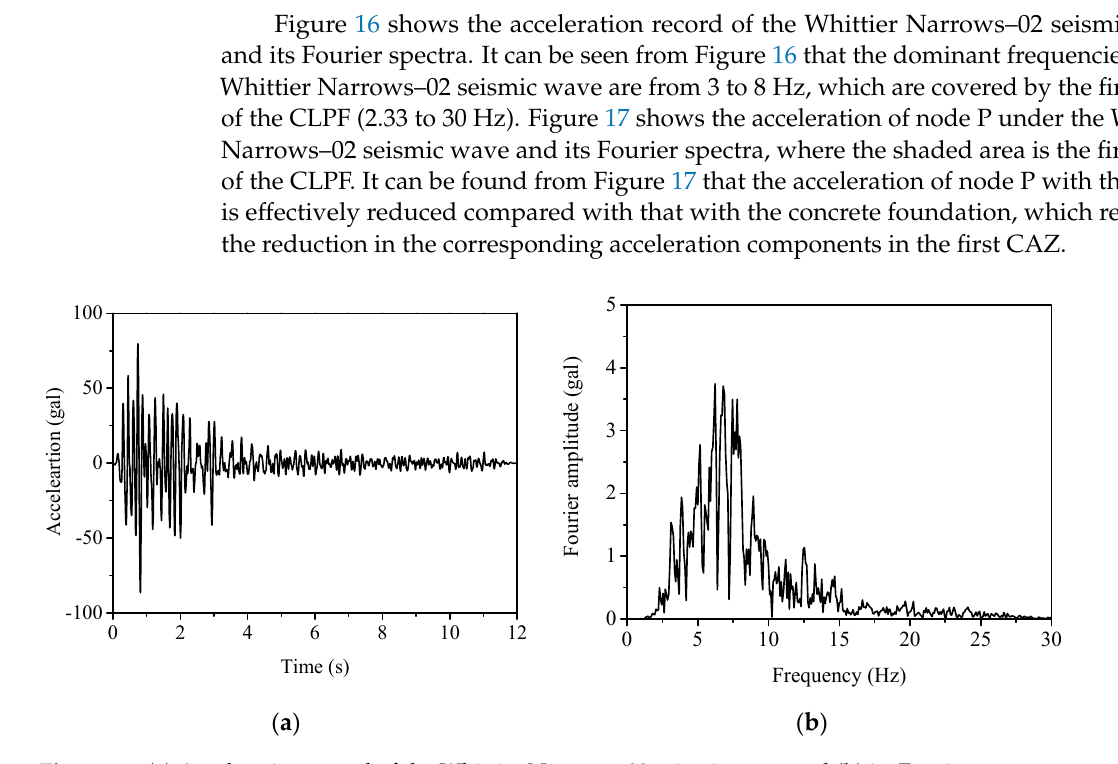
( b ) Figure 17. ( a ) Acceleration of node P under Whittier Narrows–02 seismic wave and ( b ) its Fourier spectra. Figure 18 shows the acceleration record of the Oroville–01 seismic wave and its Fou- rier spectra. It can be seen from Figure 18 that the dominant frequencies of the Oroville– 01 seismic wave are from 2.5 to 12 Hz, which are also covered by the first CAZ of the CLPF. Figure 19 shows the acceleration of node P under the Oroville–01 seismic wave and its Fourier spectra. Again, it can be seen from Figure 19a that the acceleration of node P with the CLPF is greatly reduced compared with that of the concrete foundation. Moreo- ver, it can be seen from Figure 19b that the acceleration components outside the first CAZ will be enlarged by the CLPF, which is in accordance with the essence of AZs of traditional LPFs. Figure 20 shows the maximum relative displacement of the superstructure under the Whittier Narrows–02 and Oroville–01 seismic waves. It can be seen from Figure 20 that seismic responses of the superstructure are effectively mitigated by the CLPF.